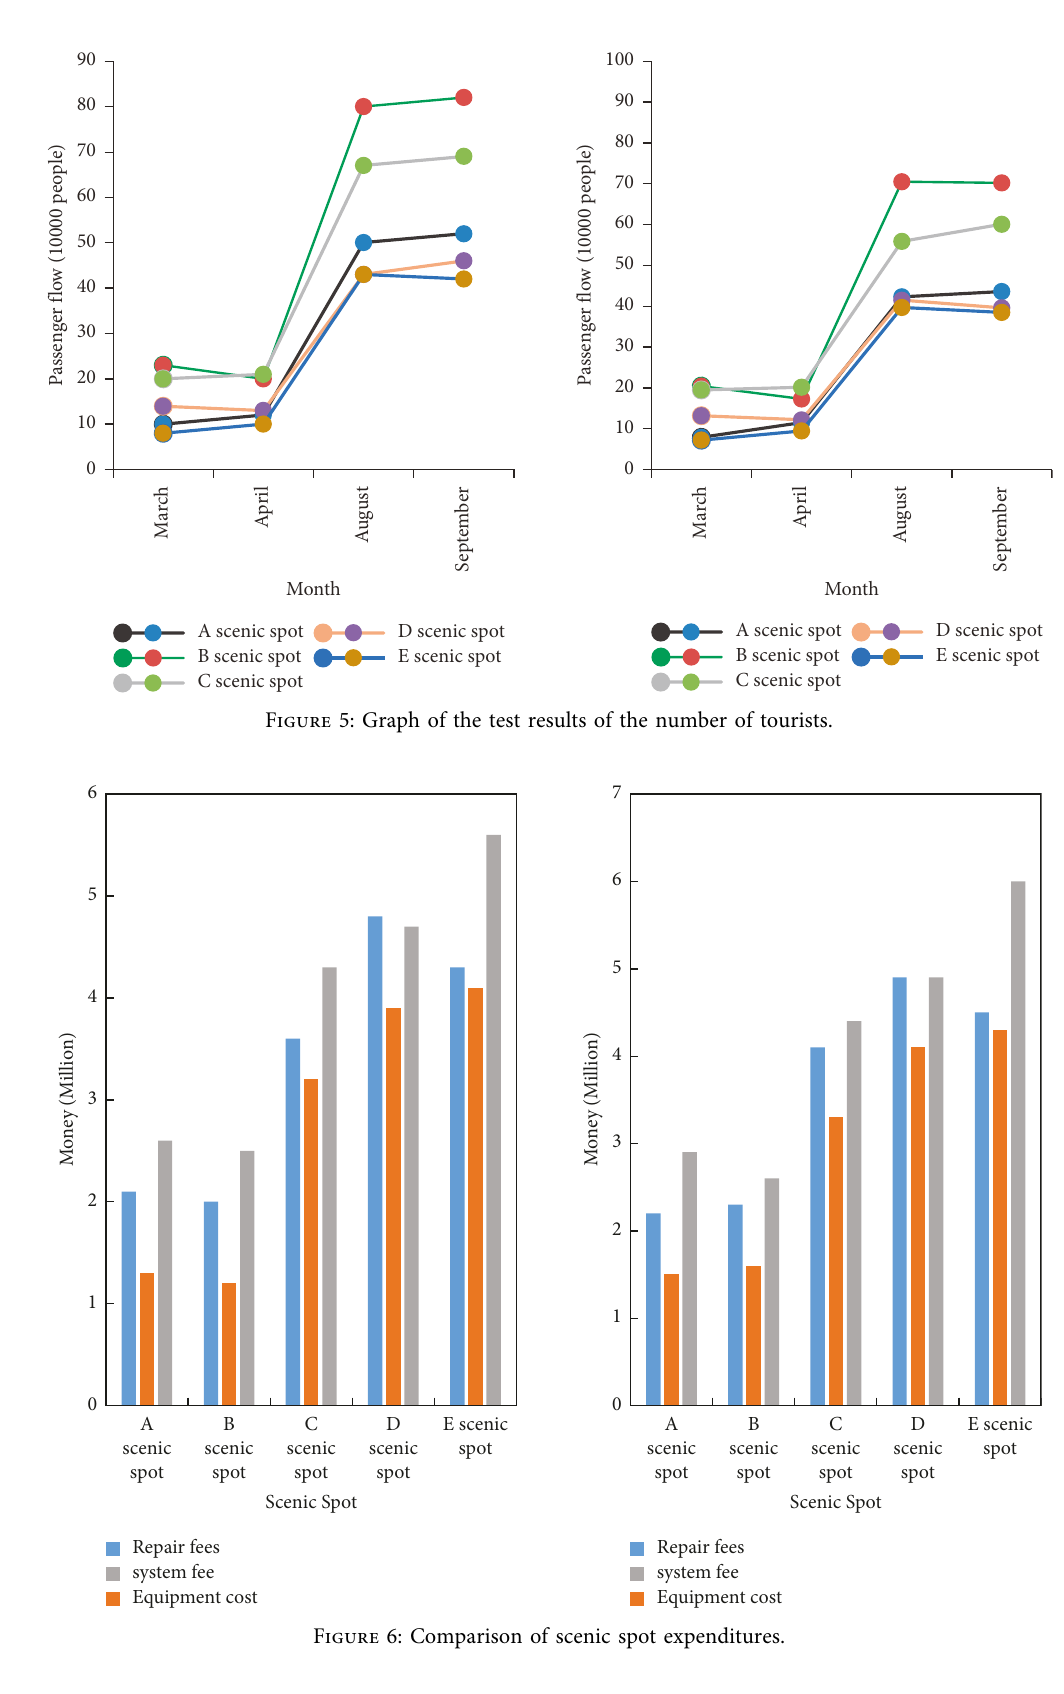
Figure 6: Comparison of scenic spot